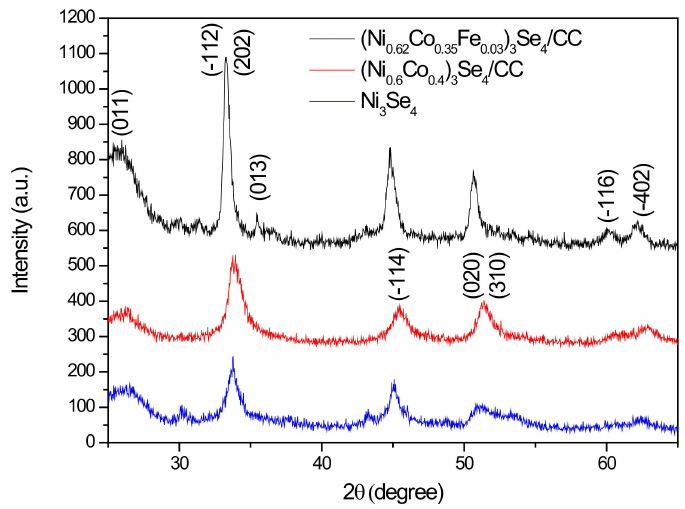
Figure 3. XRD pattern of (Ni 0.62 Co 0.35 Fe 0.03 ) 3 Se 4 /CC, (Ni 0.6 Co 0.4 ) 3 Se 4 /CC,Ni 3 Se 4 /CC.